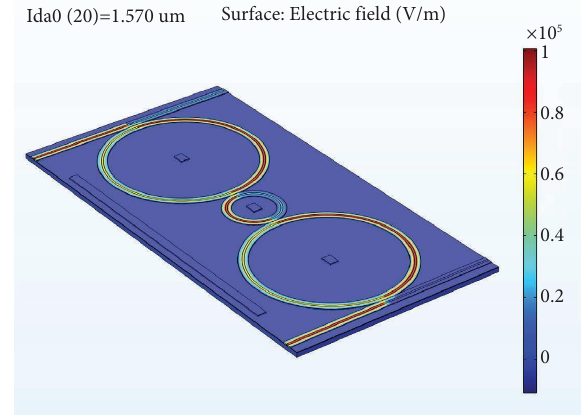
Figure 8: Electric feld profle in the flter structure at a resonance � 1570nm. A strong confnement of the electrical wavelength of λ 0 feld in the structure of the flter is observed, and at resonance, the signal exits at the drop port with very low